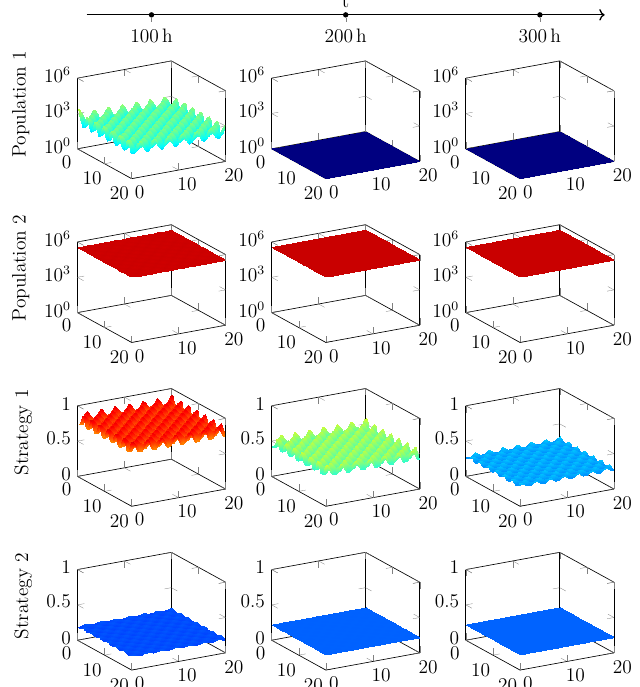
Figure A2. Evolution of two populations with different start strategies, using a G -function with private benefit and a hill factor of h = 1. Note the shorter timescale in this